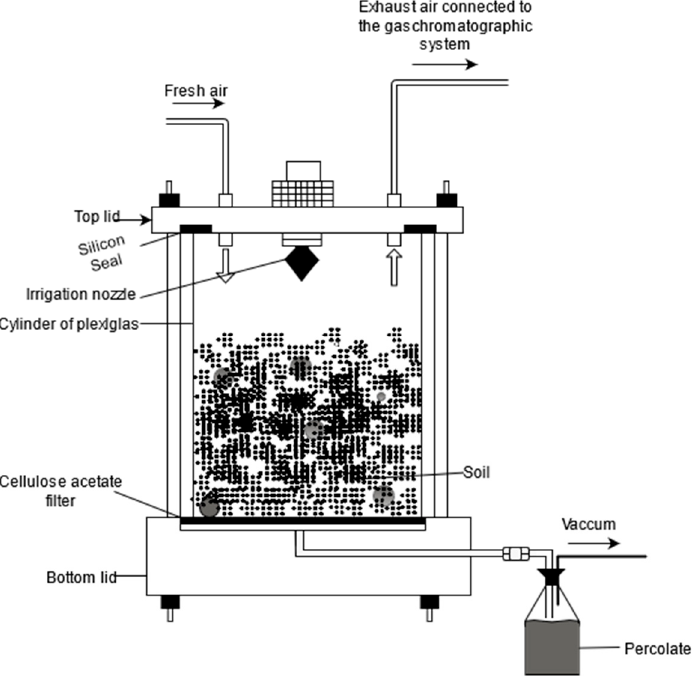
Figure 4. Individual Microcosm Design Used in this